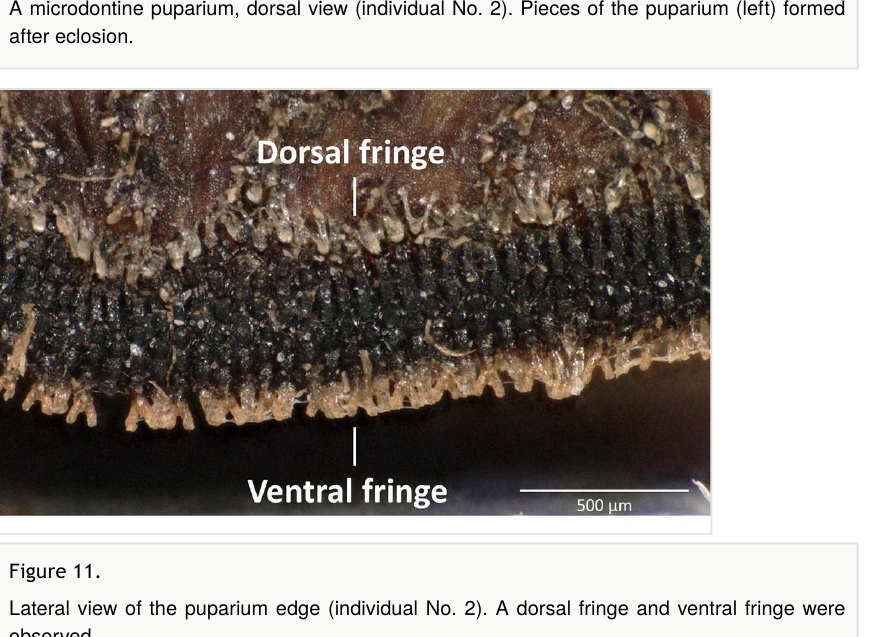
Figure 11. Lateral view of the puparium edge (individual No. 2). A dorsal fringe and ventral fringe were